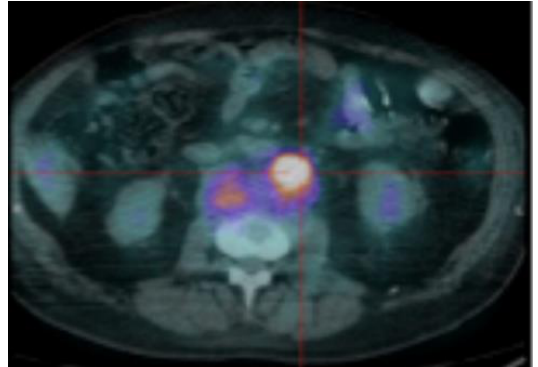
Figure 3. Extra-medullary pre-aortic hypermetabolism corresponding to an EMD.